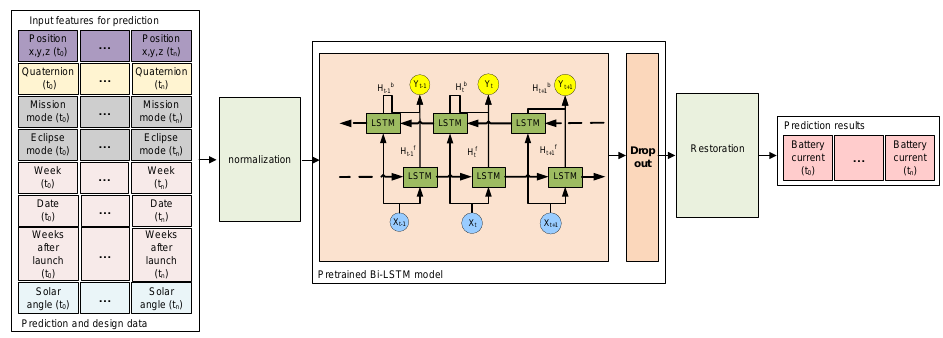
Figure 4. Proposed framework of battery current prediction.